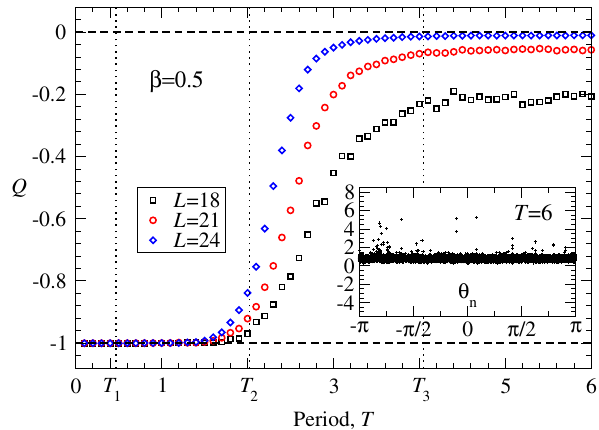
FIG. 4. Average entropy of the eigenstates h S i vs the period T . h S i = ln ð 0 . 48 D Þ crosses over from zero to the COE predic- tion, which is reached earlier as L increases. The variance hð S n − h S iÞ 2 i 1 = 2 is smaller than the size of the symbols used.